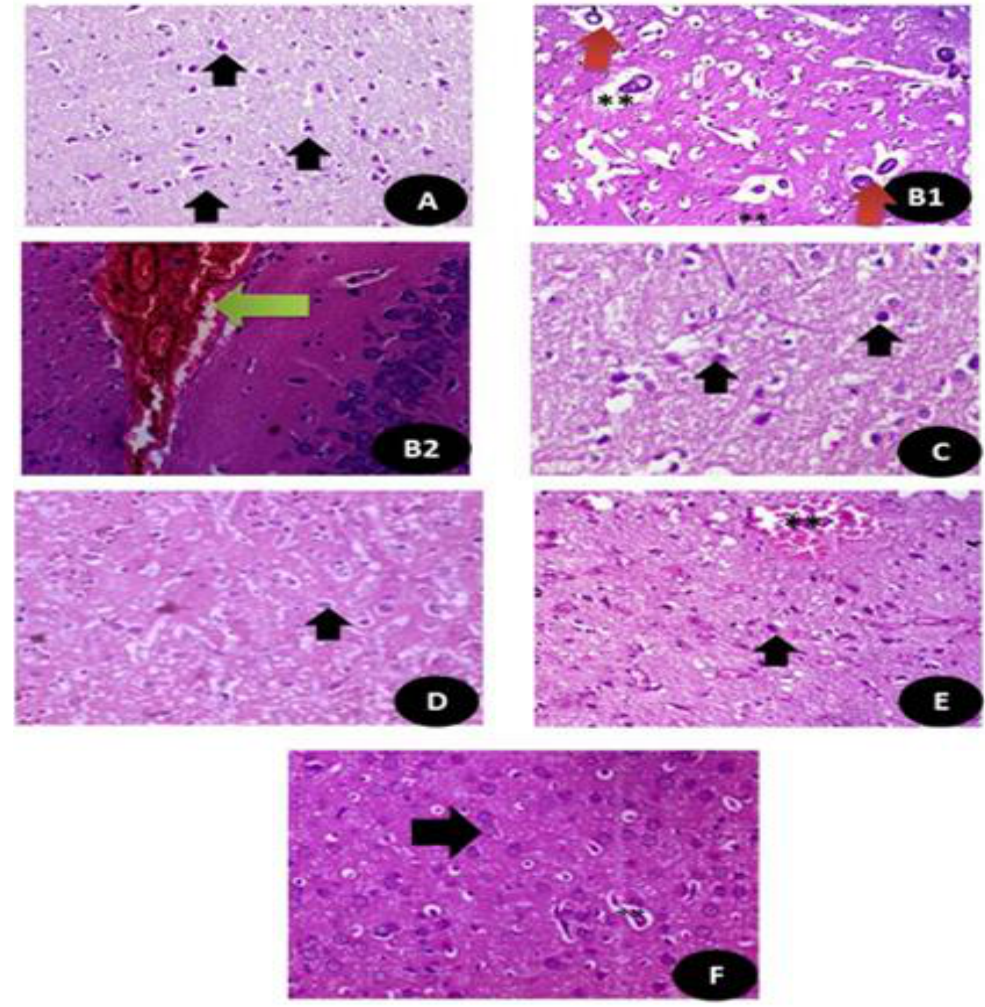
Figure 14. Histopathologicalsections of the brain stained with hematoxylin and eosin ( A ) control groups showing normal neurons and glial cells (Black arrow) (×400); ( B1 , B2 ) DG treated group showing large area of hemorrhage with high congested area (Green arrow) and appearance of disorganized pyramidal cells (Red arrow) with small dark nuclei with granular cells showing apoptotic nuclei. (**) (×400); ( C , D ) Q and Ru III /Q treated groups showing normal appearance of brain tissues normal white matter, normal neurons and glial cells (Black arrow) (×400). ( E ) DG + Q treated group showing reduction in the area of congestion (**) with restoration of the normal neurons with mild swelling (Black arrow) (×400). ( F ) DG + Ru III /Q treated group showing restoration of normal neurons and fibers (Black arrow) with still some swelling in the glial cells (**) but without congestion or necrotic areas in cells the neural (×400).